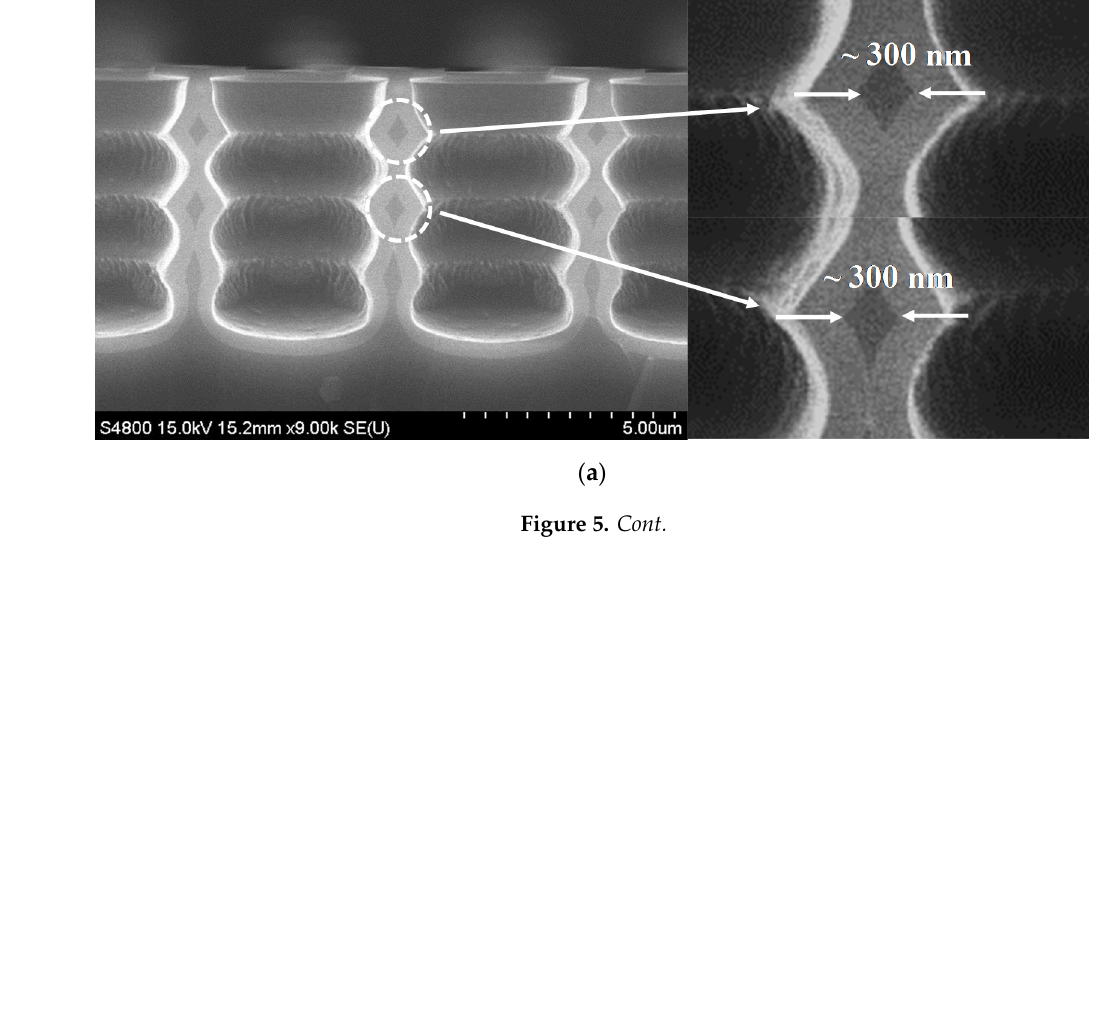
10 of 10 Table 2. Measurement results after various time duration during the DRIE process. Etching Time (s)